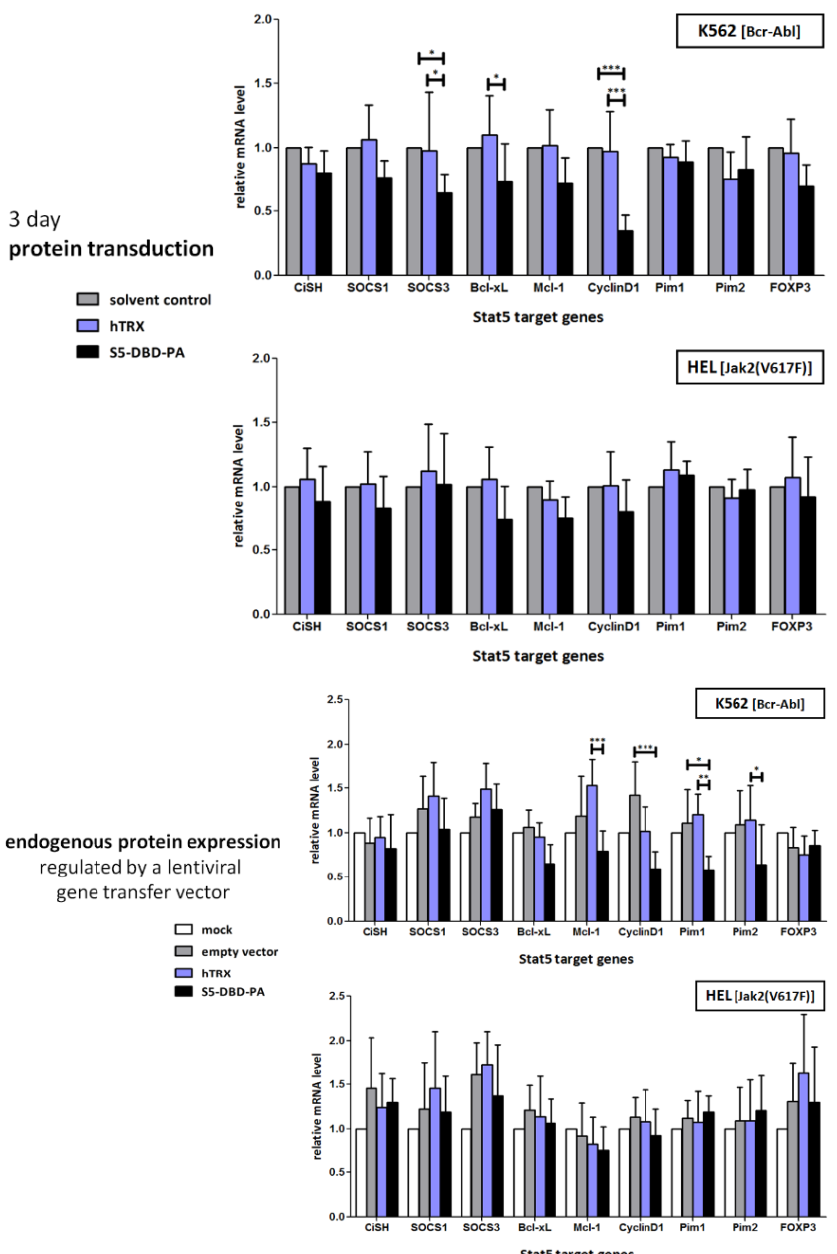
Figure 6. S5-DBD-PA interferes with Stat5 target gene transactivation in Bcr-Abl + K562 CML-cells, but not in Jak2(V617) + HEL cells. mRNA expression of selected Stat5 target genes by qRT-PCR measurements. S5-DBD-PA or hTRX scaffold control proteins were delivered into K562 and HEL cells either by protein transduction or lentiviral gene transfer. For analyzing the influence of protein transduction, cells were cultured under normal conditions and incubated for 3 days with the recombinant protein constructs. During this time S5-DBD-PA (f.c.: 1 µM), hTRX (f.c.: 1 µM) or the same volume of solvent control were added 4 times to the culture media (after 0, 24, 48 and 66 h). In a separate experiment both cell lines were infected with lentiviruses, either encoding S5-DBD-PA, hTRX or the empty vector (SiEW) and analyzed after 10 days. Cells were lyzed and total RNA was extracted for qRT-PCR measurement. Data were normalized to HPRT1 housekeeping